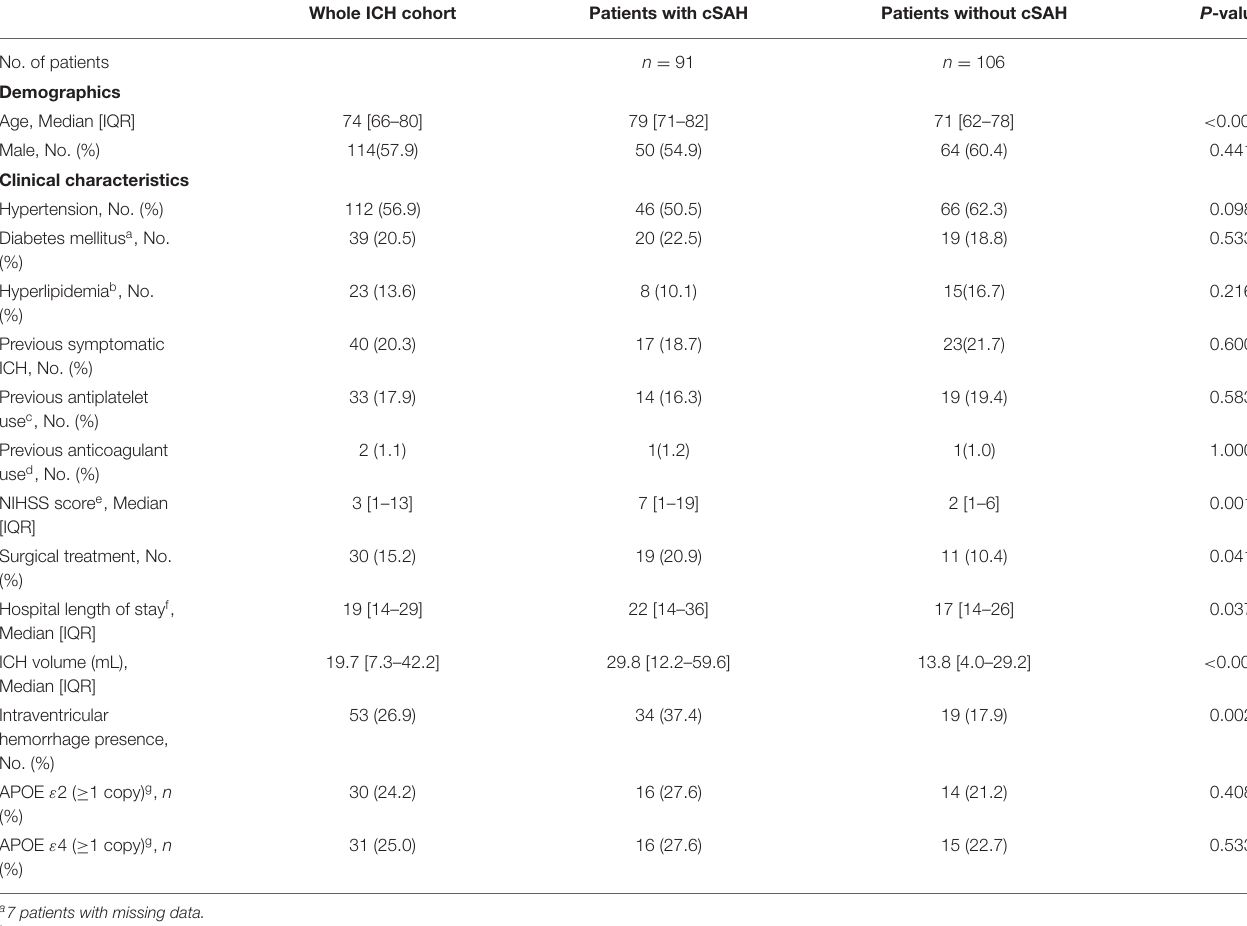
TABLE 1 | Baseline characteristics and comparison of patients with and without cSAH. Whole ICH cohort Patients with cSAH Patients without cSAH